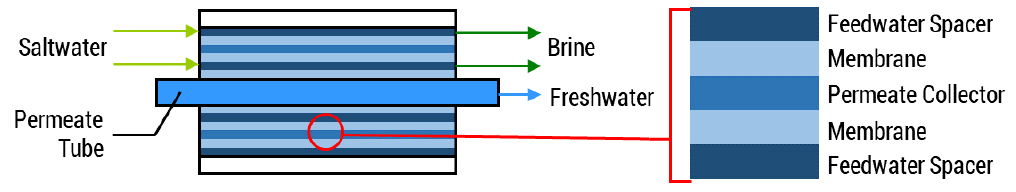
Figure 1. Reverse Osmosis (RO).